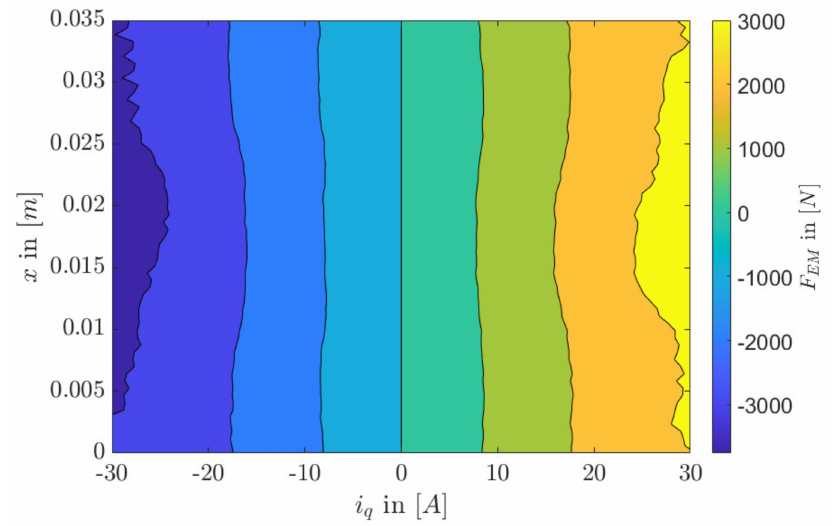
Figure 5. Force F EM depending on position x and current i q